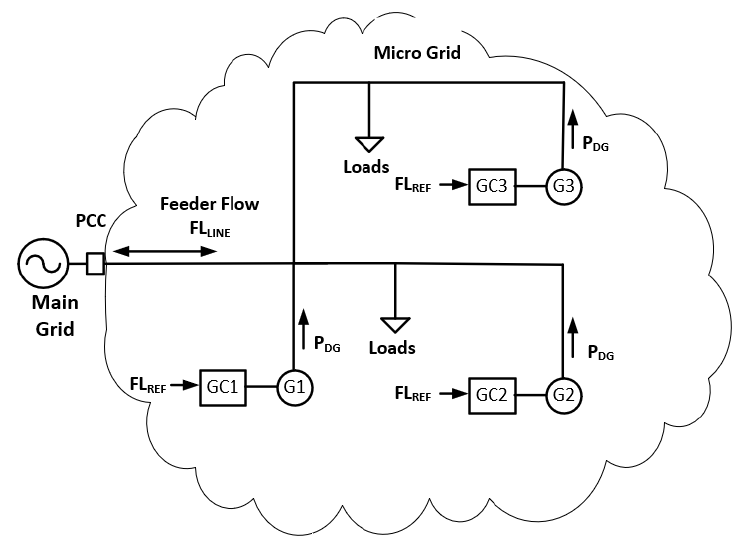
Figure 2. FFC mode of operation.